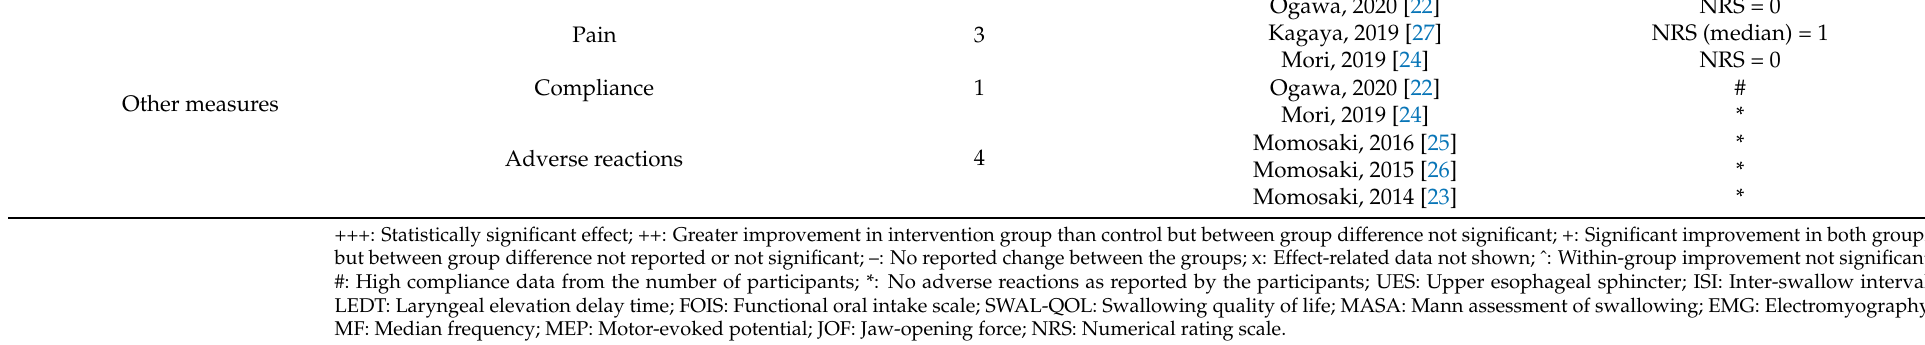
Number of Studies That Assessed This Outcome